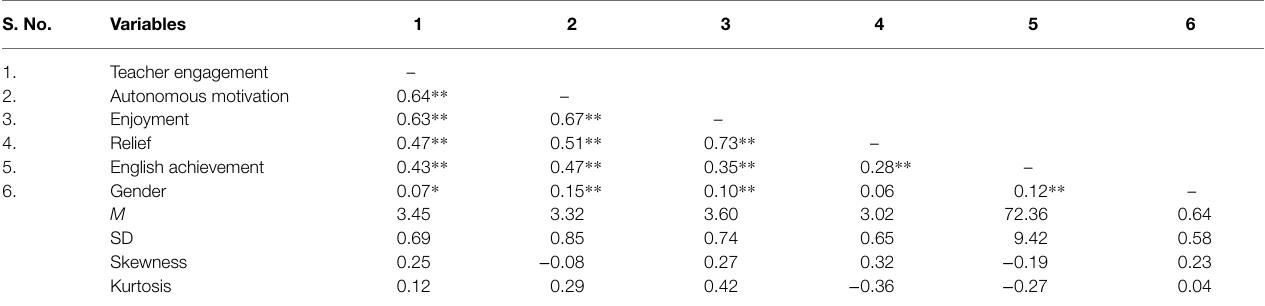
TABLE 1 | Descriptive statistics and correlations among main measures.